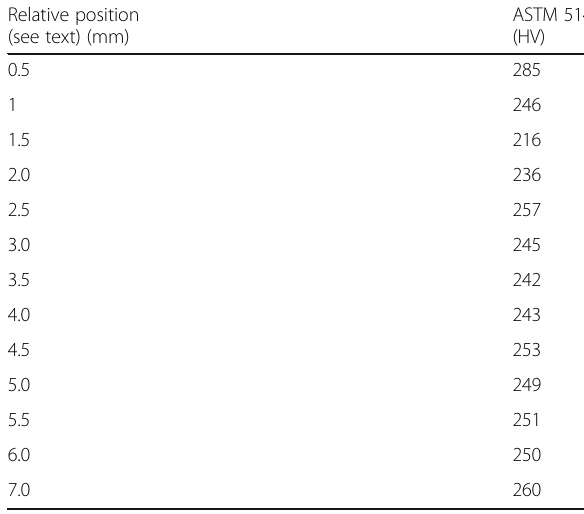
Table 3 Idem for and ASTM A 514 grade